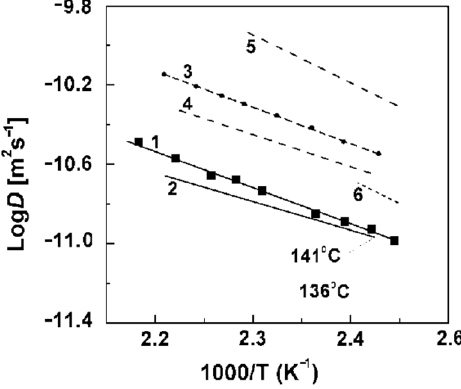
Figure 43. Temperature dependences of the diffusion coefficients of composite materials: 1, D s obtained by PFG NMR for the composition CsHSO 4 -Cs 3 (HSO 4 ) 2 (H 2 PO 4 ) = 1:1; 2, D s obtained by PFG NMR CsHSO 4 [134]; 3, D s calculated from Equation (7) for the composition CsHSO 4 -Cs 3 (HSO 4 ) 2 (H 2 PO 4 ) = 1:1; 4, D s calculated from Equation (7) for CsHSO 4 ; 5, D s calculated from Equation (7) for β-Cs 3 (HSO 4 ) 2.5 (H 2 PO 4 ) 0.5 ; 6, D s calculated from Equation (7) for α- Cs 3 (HSO 4 ) 2 (H 2 PO 4 ) [89].